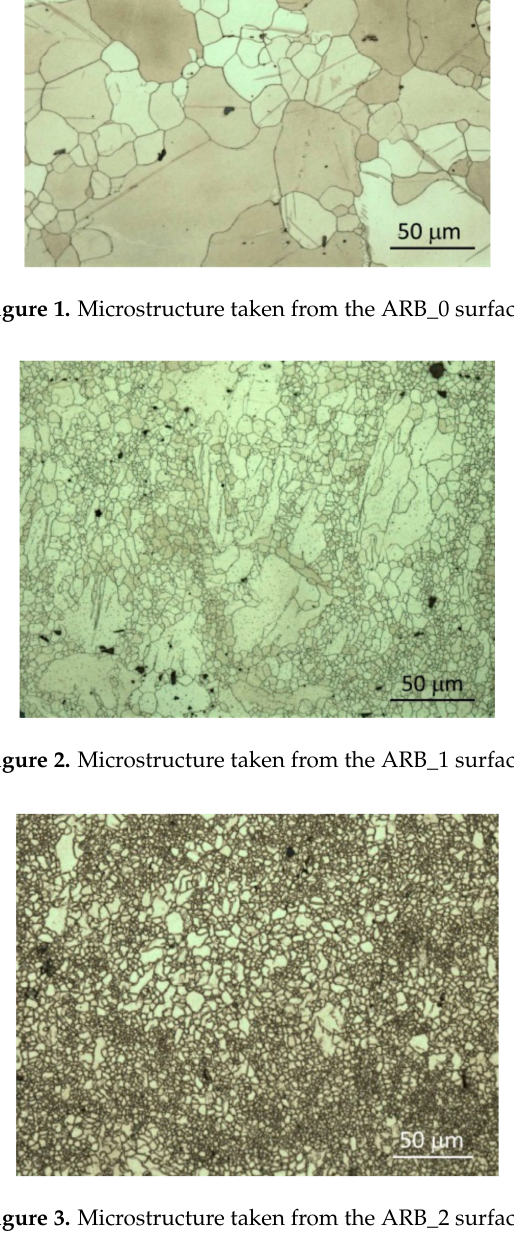
Figure 3. Microstructure taken from the ARB_2